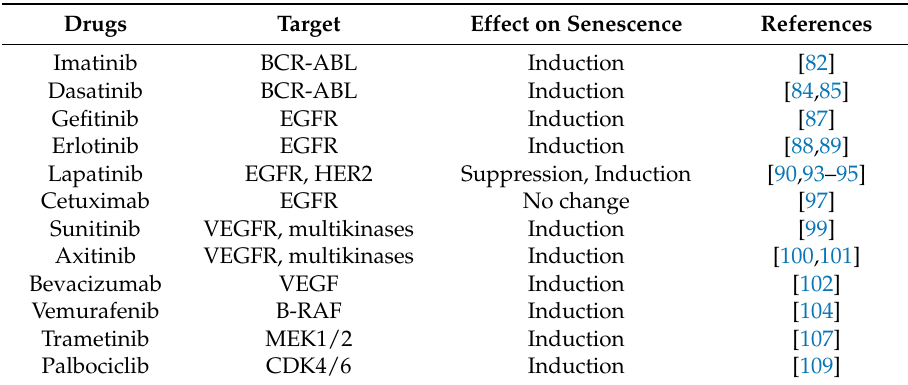
Table 1. FDA-approved kinase modulators and cellular